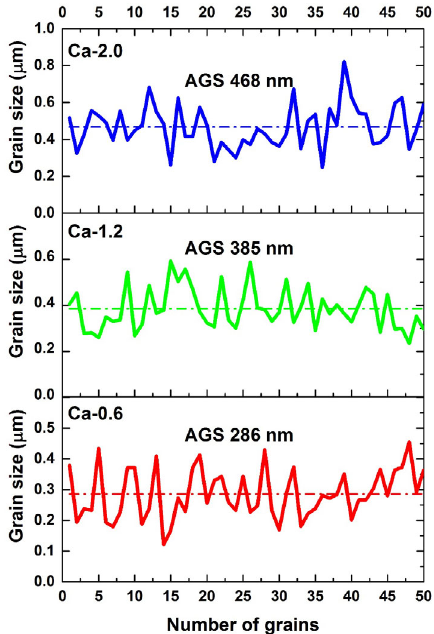
Fig. 8 Grain size distribution of nitrogen rich samples synthesized at 1500 ℃ having the sample ID of Ca-0.6, Ca-1.2, and Ca-2.0.